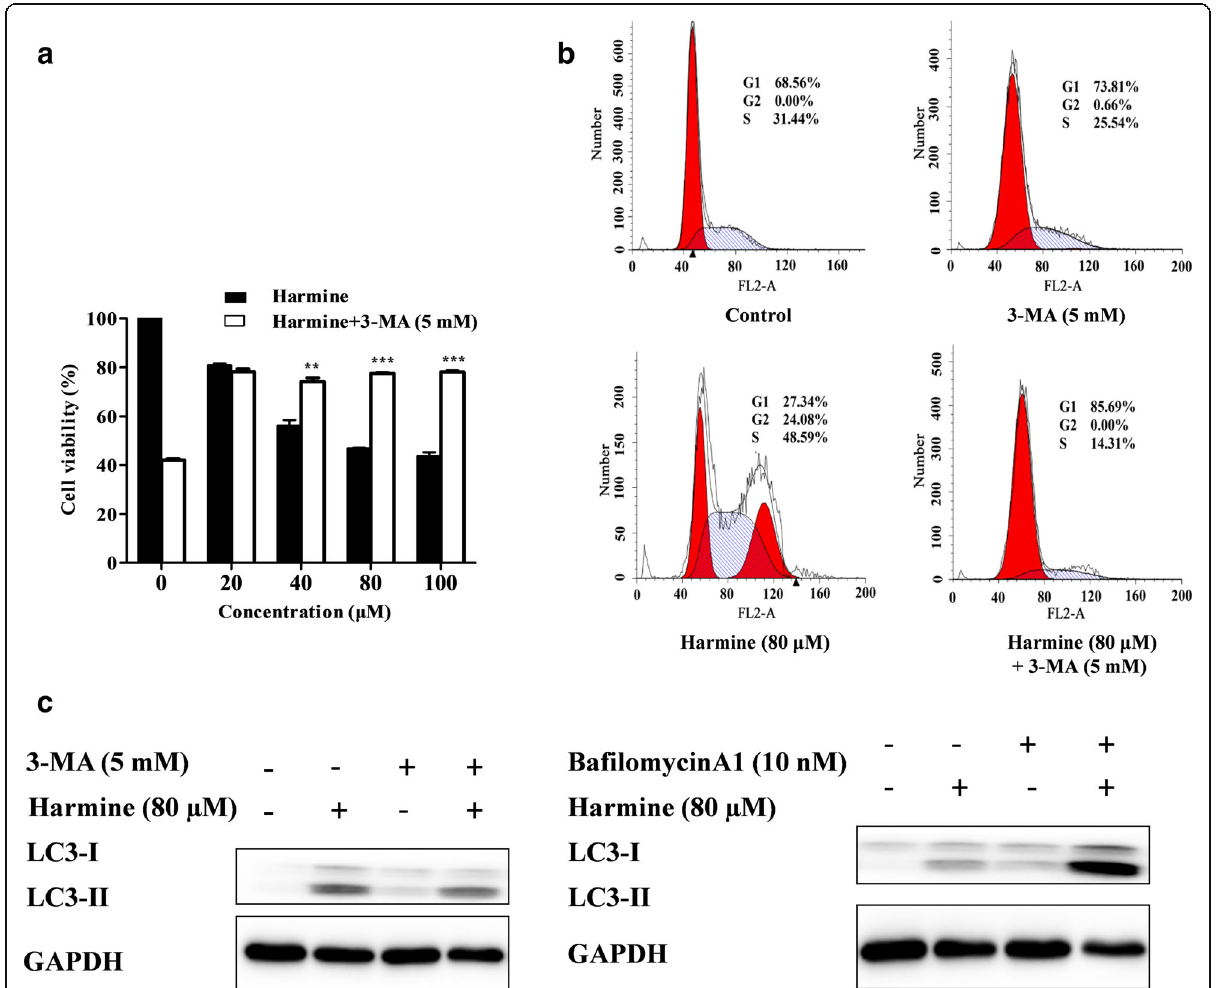
Fig. 5 Harmine affected autophgic flux and the relation of autophagy and apoptosis. a: The effects of 3-MA (5 mM) on harmine induced B16 cells viability; b: The cell cycle distribution of B16 cells treated with harmine (80 μ M) and combine with 3-MA (5 mM) for 24 h; and c: the protein expression of LC3-II of B16 cells treated with harmine (80 μ M) and combine with 3-MA (5 mM) or bafilomycin A1 (10